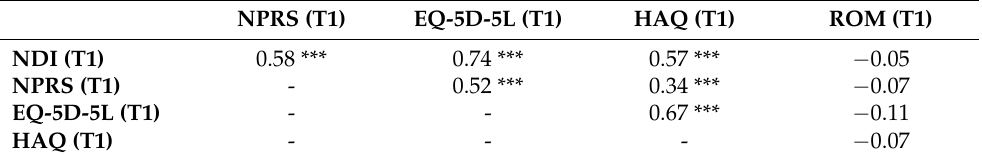
Table 2. Correlations of PROs and ROM score at baseline ( T 1).